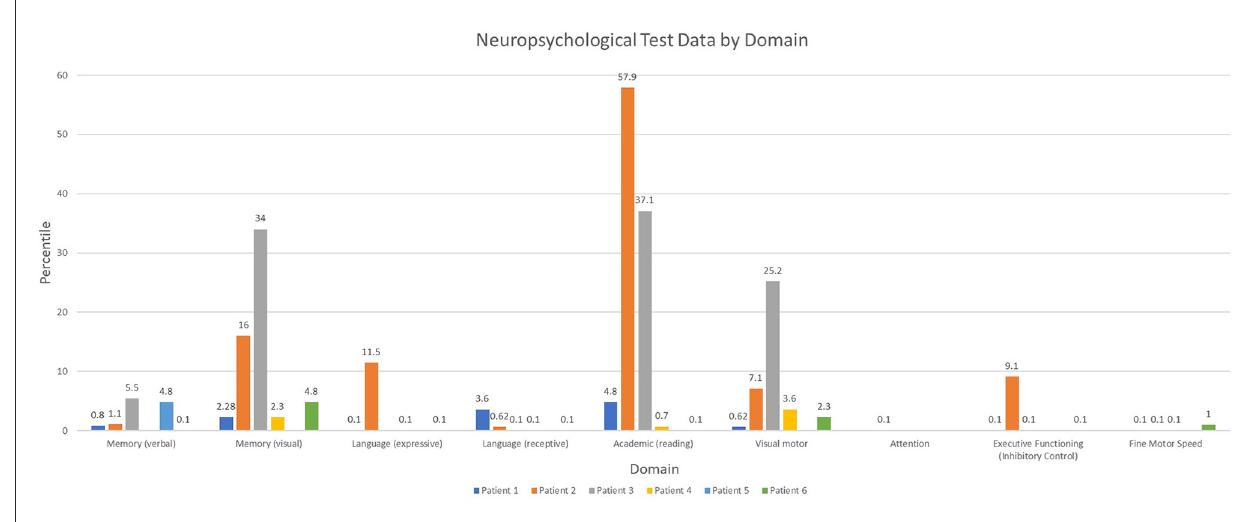
FIGURE2 Neuropsychological test data by domain at the time of last assessment.